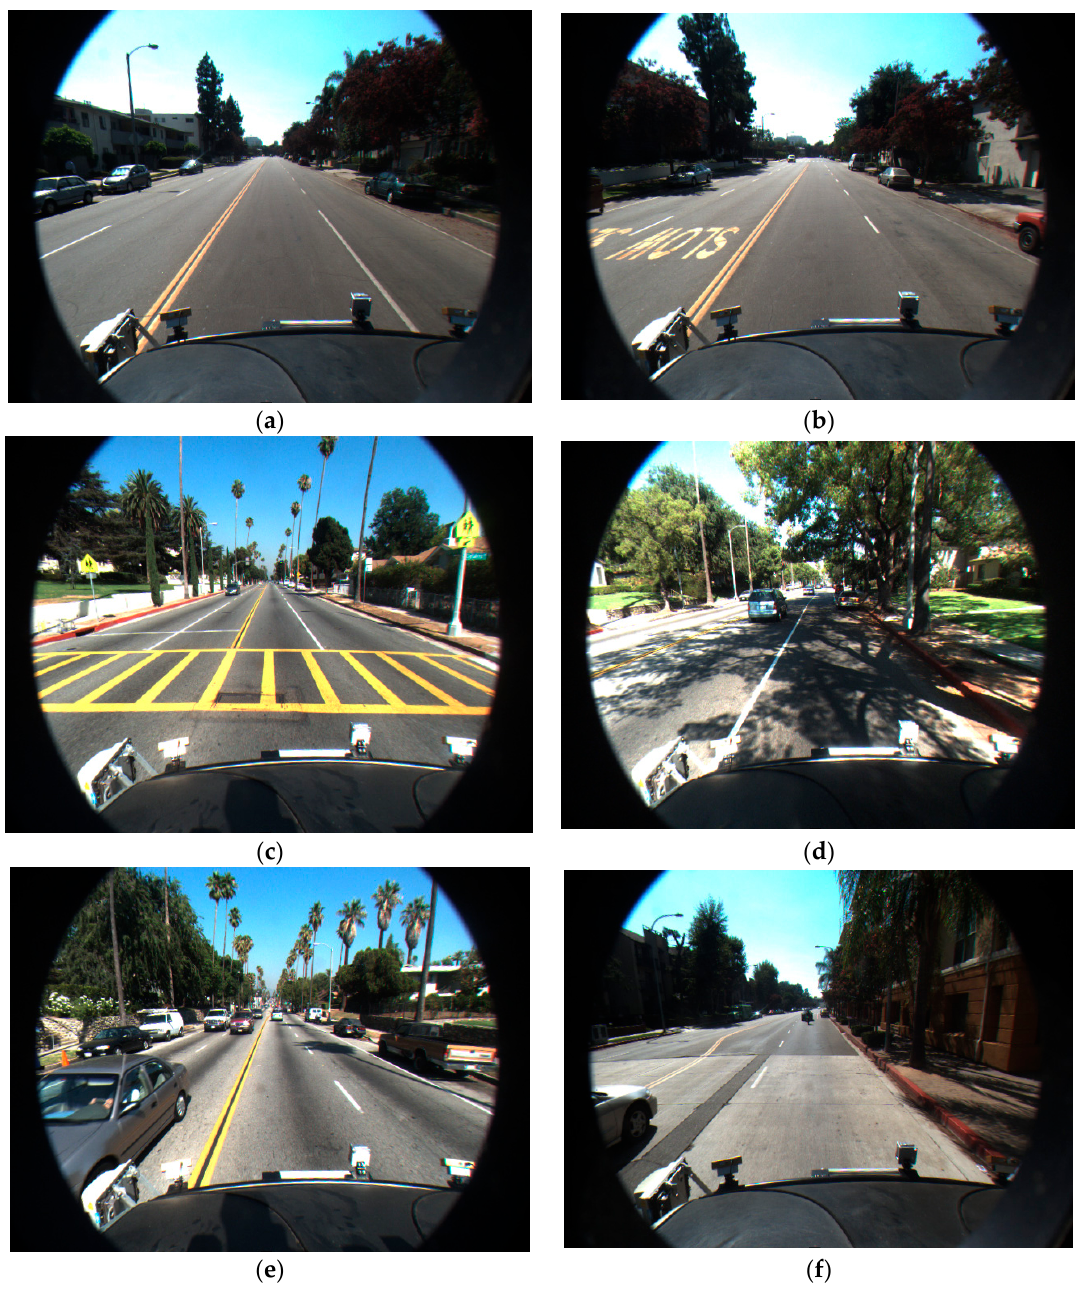
Figure 2. Examples of input images: ( a ) input image without road markings, crosswalk and shadow; ( b ) input image including road markings; ( c ) input image including crosswalk; and ( d – f ) input images including shadow.